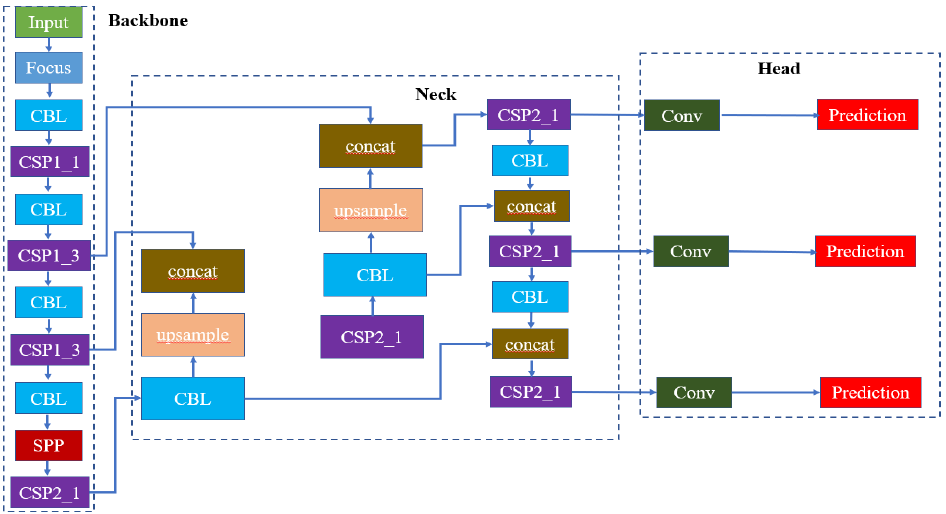
Figure 2. YOLOv5s network structure.